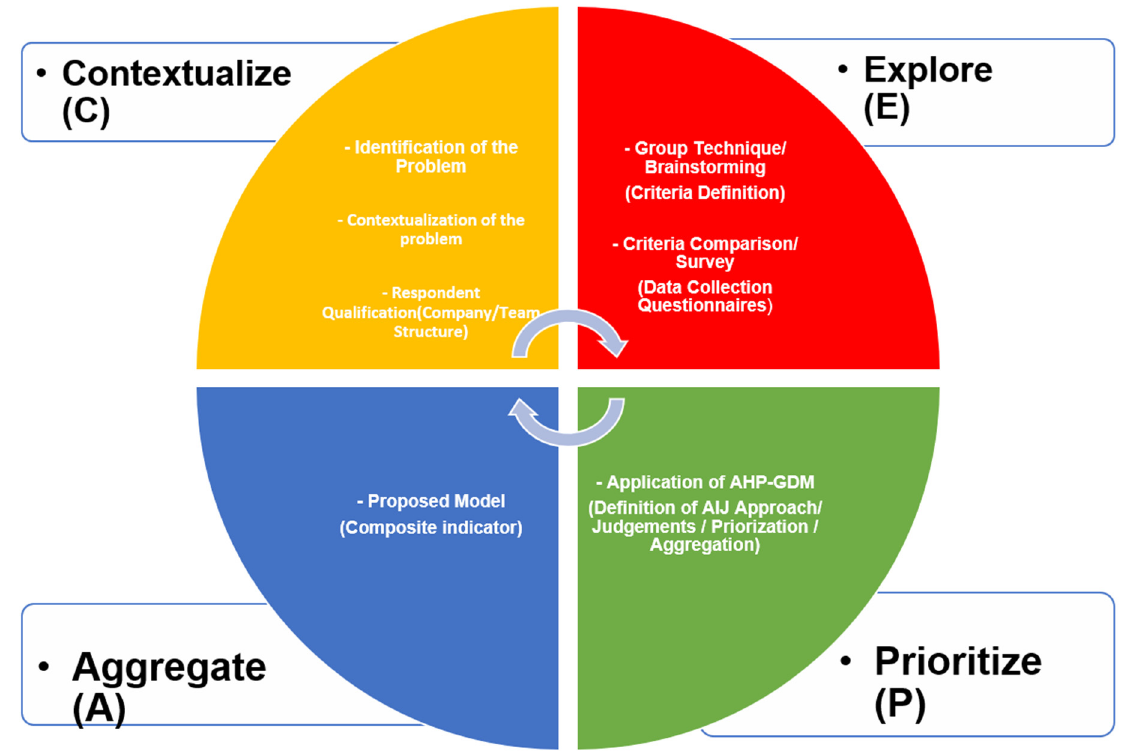
Figure 2. Research method application steps.